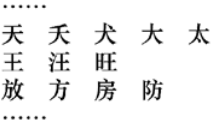
Figure 10: A Part of the Confusing-Character Table.